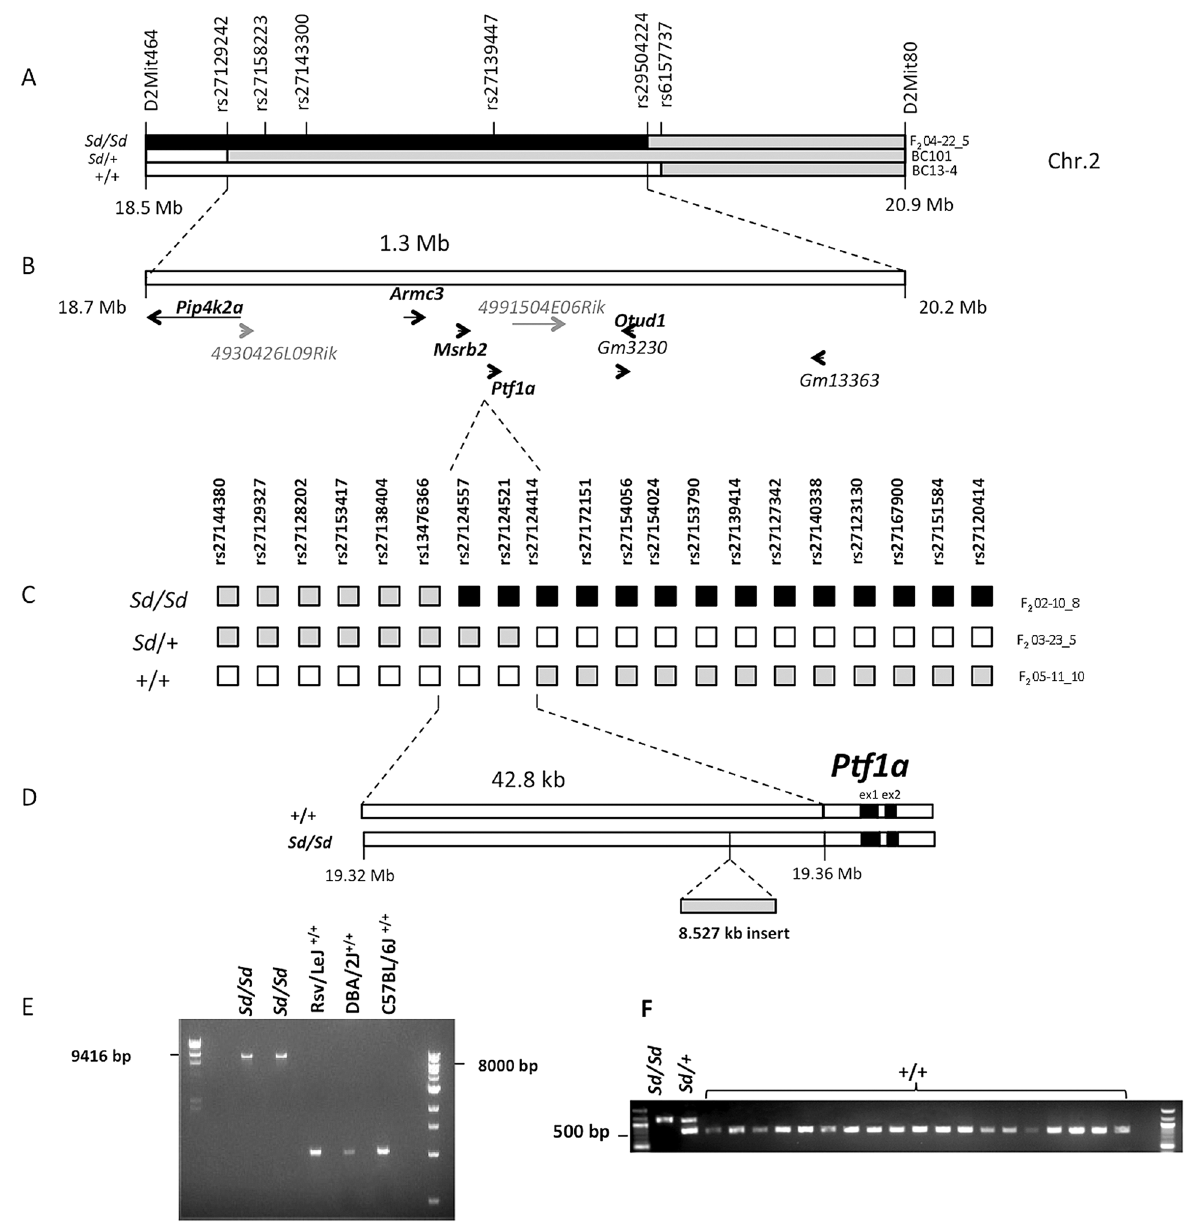
Figure 1. Fine mapping and identification of the Sd mutation. (A) Meiotic mapping on mouse Chr.2 on 174 backcross (BC) and 120 F2 intercross mice refines the Sd locus to a 1.3 Mb interval. The critical recombinants in 2 BC and 1 F2 mice are shown. The phenotype of each mouse ( Sd/Sd, Sd/ + and + / + ) is indicated on the left. The genotypes are indicated by the color of each haplotype: black=RSV/RSV genotype; gray=RSV/B6 genotype; white=B6/B6 genotype. The location of genotyped markers is indicated above the haplotypes. (B) The initial mapping localized the Sd mutation to a 1.3 Mb interval on Chr. 2 between rs27129242 and rs29504224. This region contains 9 genes, of which five have mammalian orthologs (shown bold black). Predicted genes without mammalian orthologs are indicated in gray. (C) High resolution mapping in 1203 F2 mice. The critical recombinants in 3 F2 mice are shown. The phenotype and genotypes are indicated as in (A). (D) Localization of the Sd mutation to a 42.8 kb interval between rs13476366 and rs27124414, 12.2 kb upstream of the Ptf1a start site and identification of an insertion of 8.5 kb in the Sd/Sd mouse. (E) Long- range PCR identifies the insertion in 2 different mice Sd/Sd mutants but not in the RSV/LeJ strain and the two counterstrains used in the mapping study (C57BL/6J and DBA/2J). (F) Genotyping identified the insertion in Sd/Sd , and Sd/ + samples but not in any additional mouse strain tested, including 4 wild-derived and 15 other laboratory inbred strains (listed in methods). also genotyped this insertion in a random sample of 142 mice from RSV/LeJ- Sd/Sd sequence otherwise shows identity with the the F2 mapping progeny and found that it perfectly segregated C57BL/6J reference sequence (Figure 1F). with the heterozygote and homozygote Sd phenotypes. There were Sequence comparison with Repbase data indicated that the no other variants distinguishing RSV/LeJ- Sd/Sd from RSV/LeJ- insertion is an endogenous retroviral element, with the closest + / + within the 42.8 kb minimal recombinant intervals, and the alignment with the early retrotransposon (ETn) subtype (Figure 2A